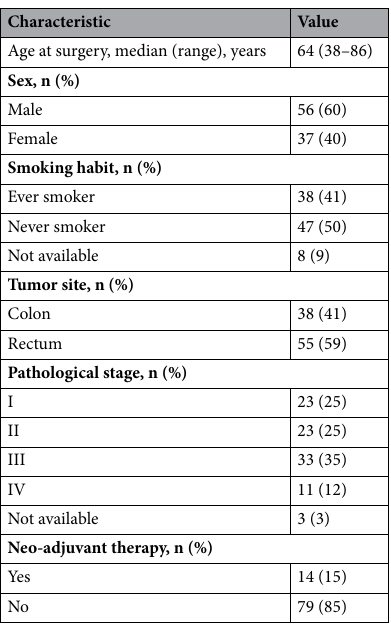
Table 1. Clinical characteristics of 93 patients with colorectal